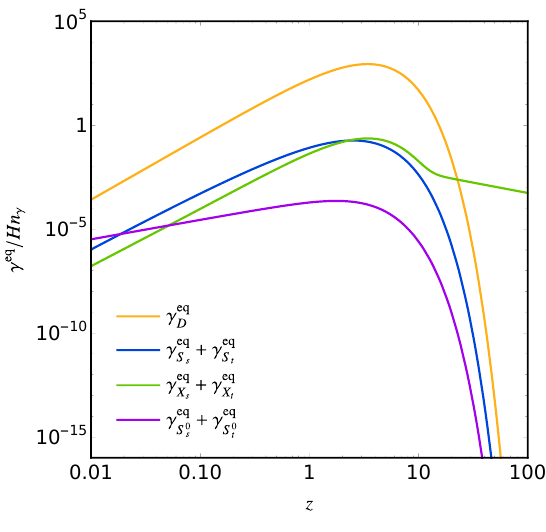
Figure 16 . Equilibrium decay and scattering rates with respect to z = m X /T and f ud = f dd = dd 0 . 05 for the high-scale scenario with m = 10 14 GeV, m = 5 TeV and λv 0 = 1 . 5 m . The X dd X ud X dd solid orange line shows the decay rate of X , while the solid (dashed) blue, green, and purple lines dd show the scattering rates S ( S ), X ( X ), and S 0 ( S 0 ) respectively. For the notation see section 3. s t s t s t . The plots in the left and right columns correspond to the choices m = 10 14 GeV X X dd dd and m = 10 13 GeV, respectively. Furthermore, a final baryon asymmetry greater X dd